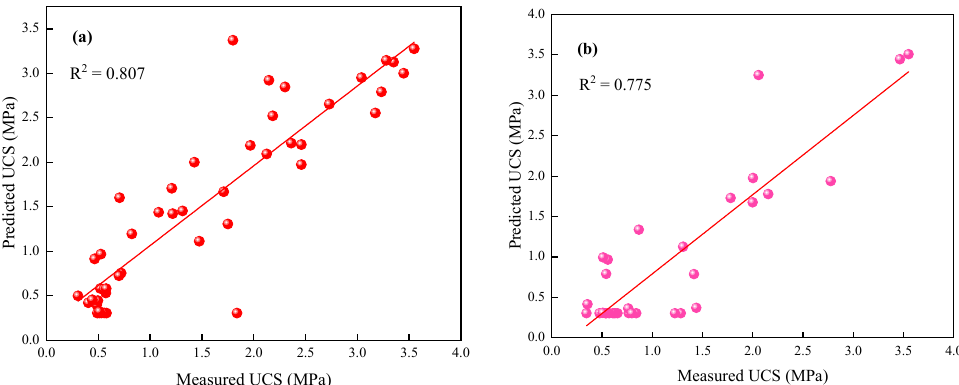
Figure 13. ANN model M3 results for UCS plotted against the measured data for the ( a ) training and ( b ) testing data.